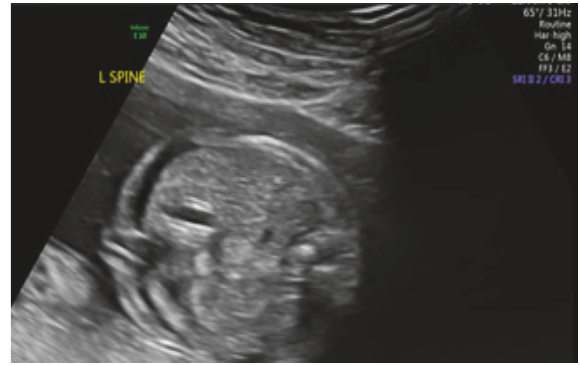
Figure 2: Anatomyultrasound at 20 weeks’ and 1-day gestation with fetal ascites.